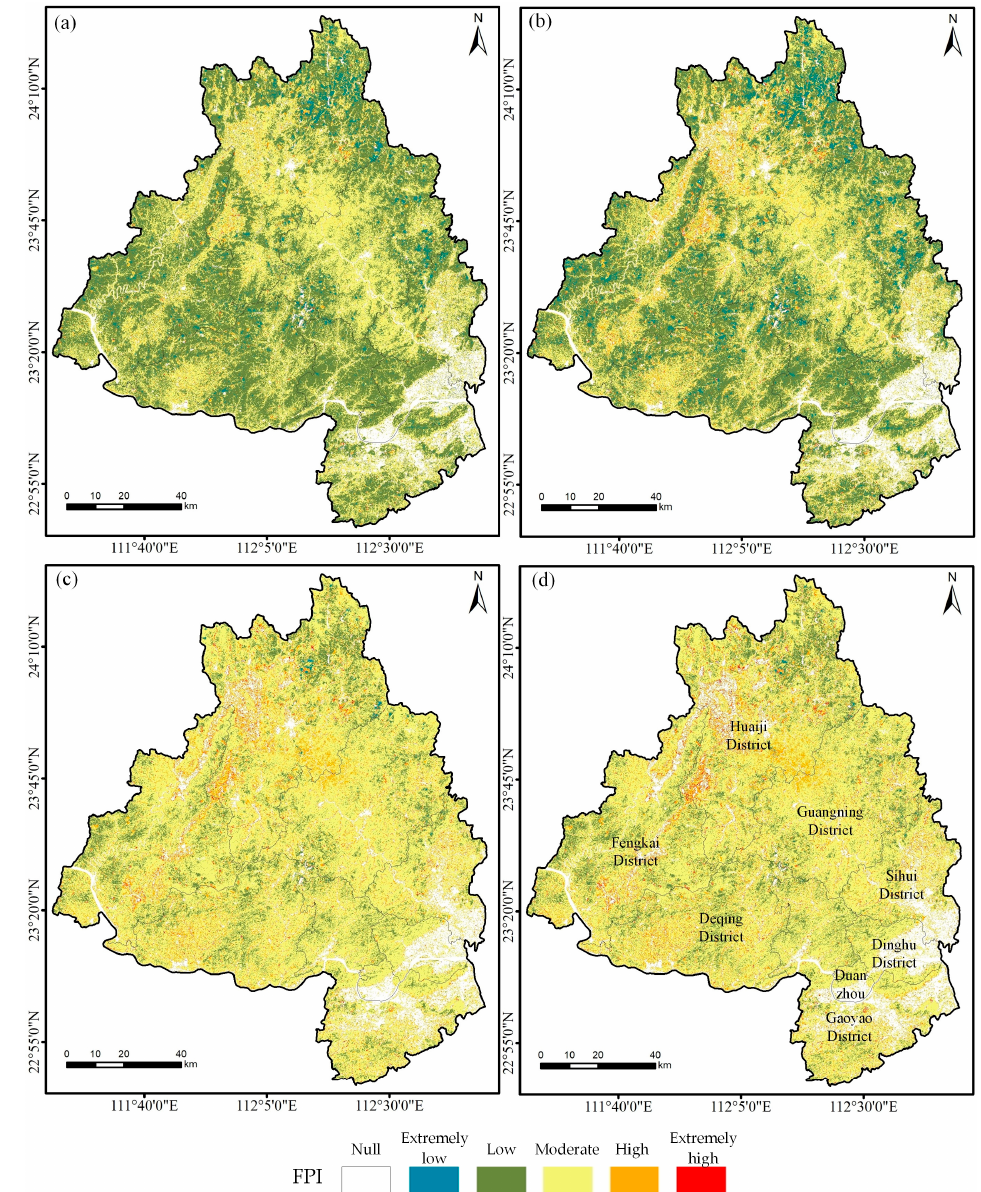
Figure 3. Forest fire risk in Zhaoqing, based on the FPI model. 20 October ( a ), 5 November ( b ), 21 November ( c ) and 7 December ( d ), 2019.